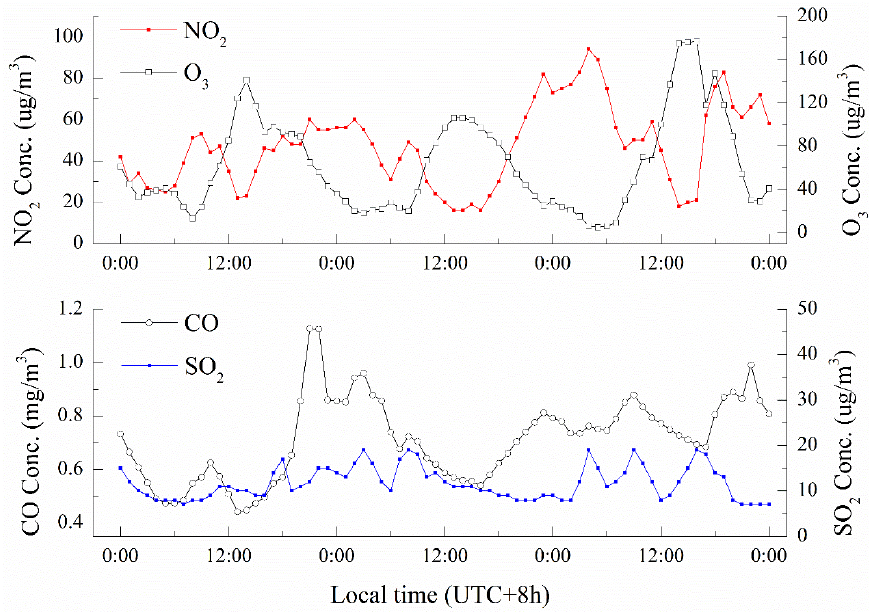
Figure 8. Diurnal variations in trace gases concentrations (NO 2 , O 3 , CO and SO 2 ).